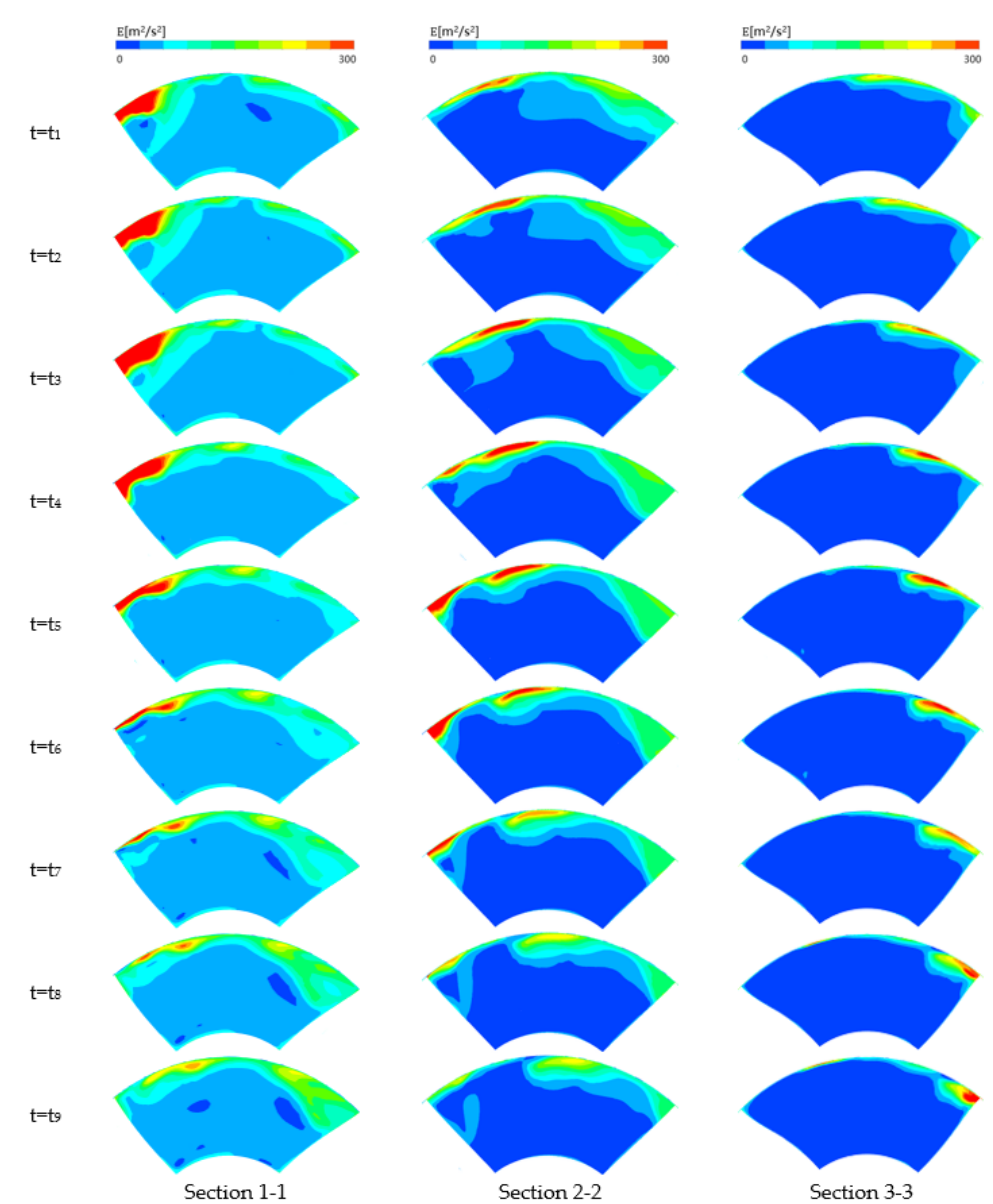
Figure 14. The vortex kinetic energy change of a typical section at different times.